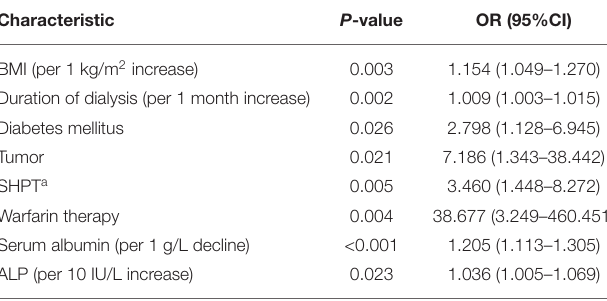
TABLE 4 | Multivariate logistic regression analysis to determine risk factors of calciphylaxis in hemodialysis patients.